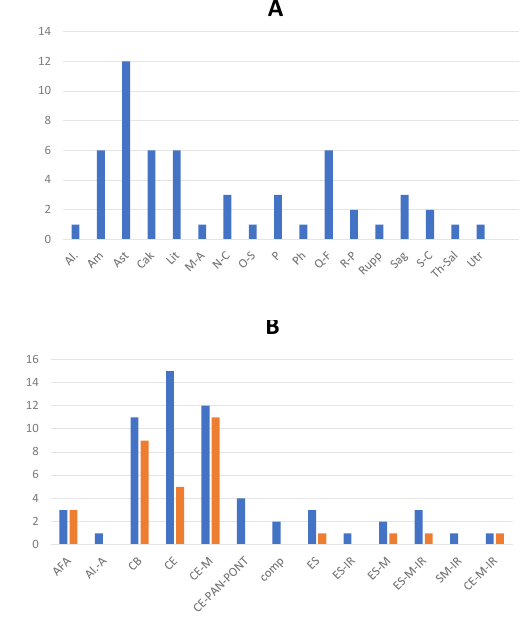
Fig. 2 Species characterized Pomerania. ( A ) Syntaxonomical affiliation. ( B ) Geographical element: general classification (blue), ranges extended to the At- lantic region of Europe (red). ( A ) Explanations: Al – Alnetea glutinosae ; Am –